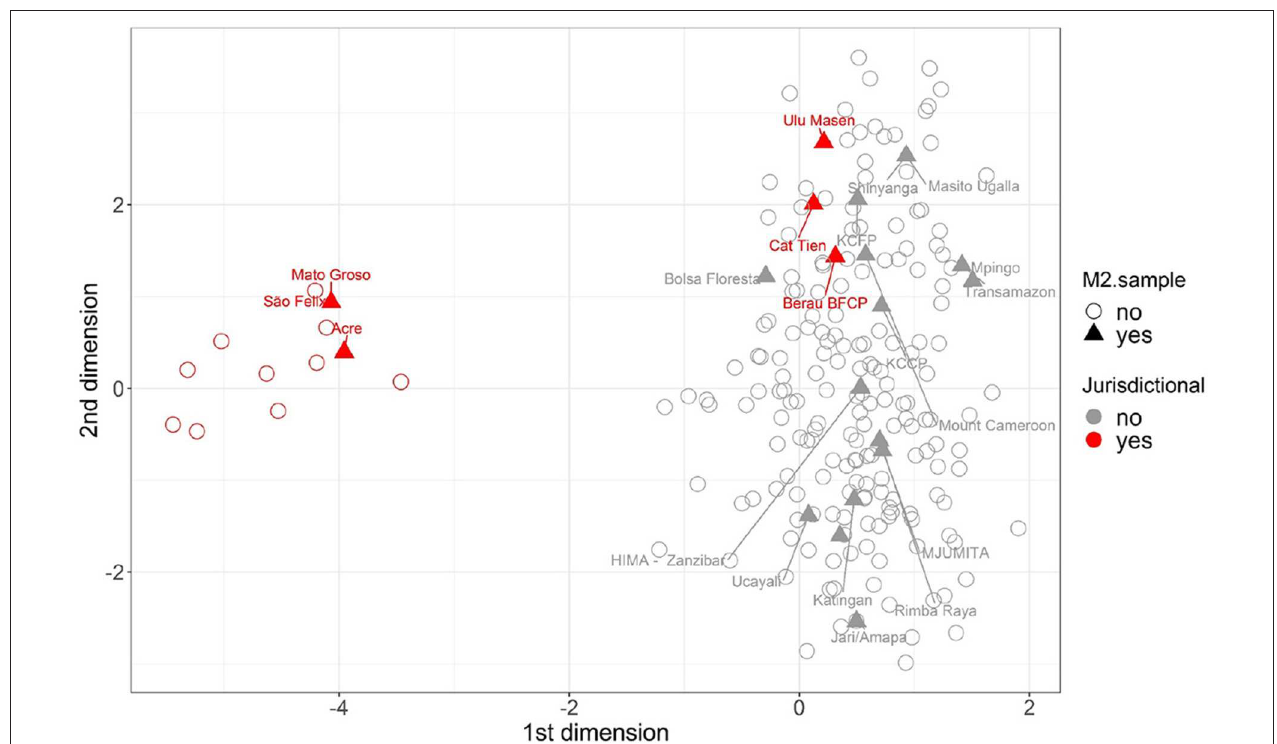
FIGURE 2 | Principal component analysis for REDD projects and jurisdictional initiatives in ID-RECCO database. Data source: ID-RECCO database,